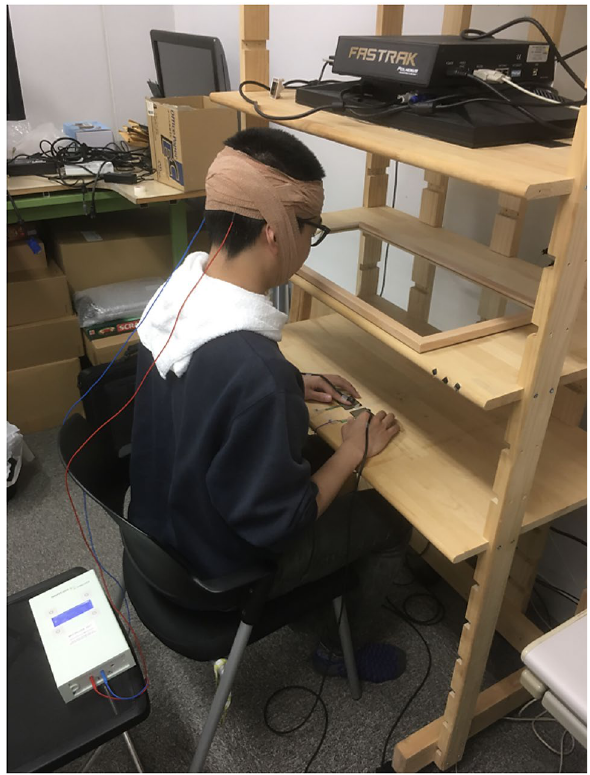
Figure 1. Experimental setup. A display was installed facing downward on a shelf situated above the participant’s visual field. The picture was projected on a mirror placed halfway between the display and the table surface. By viewing the stimuli on a mirrored surface, the participants could gain the impression that the stimuli were on the same plane as their hands. The position of the hands was indicated by two black dots on the reflected display; these points corresponded to the position of three-dimensional motion-tracking sensors worn on both index fingers by the